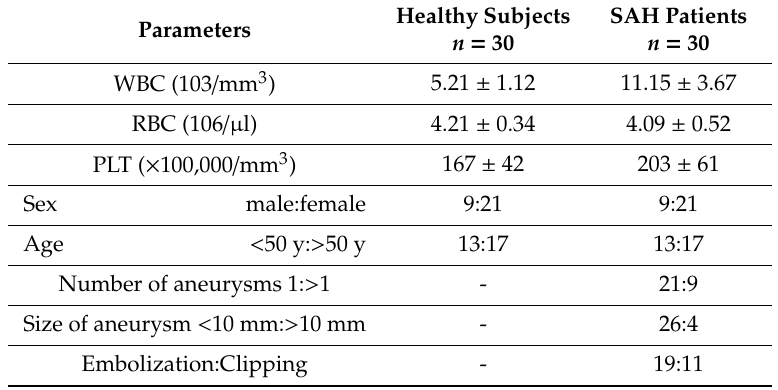
Table 3. Results of blood laboratory tests of healthy subjects and patients with